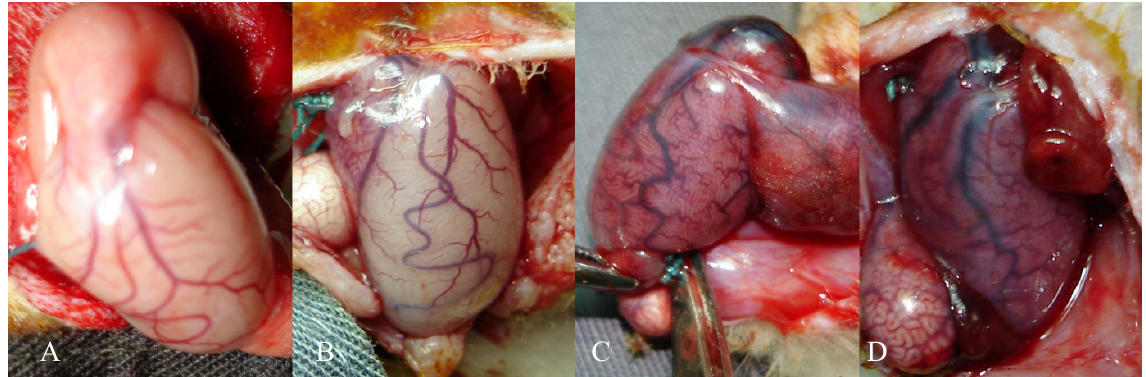
FIGURE 1 – Macroscopic appearance of the testis in the control group ( A ), and after 1 hour ( B ), 2 hours ( C ), and 4 hours of 1,080-degree torsion ( D